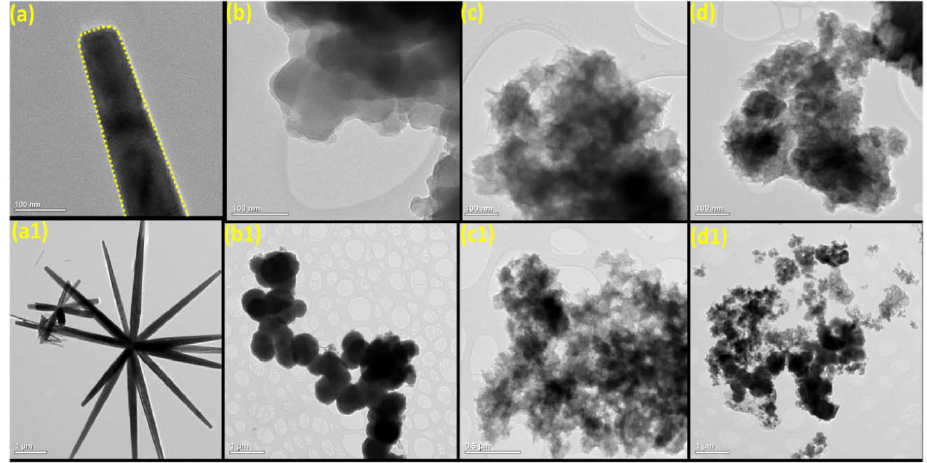
Figure 2. Transmission electron microscopy images of ( a ) Z ( b ) ZN ( c ) ZNP ( d ) ZNPM and the corresponding high magnification images (a1, b1, c1 and d1).